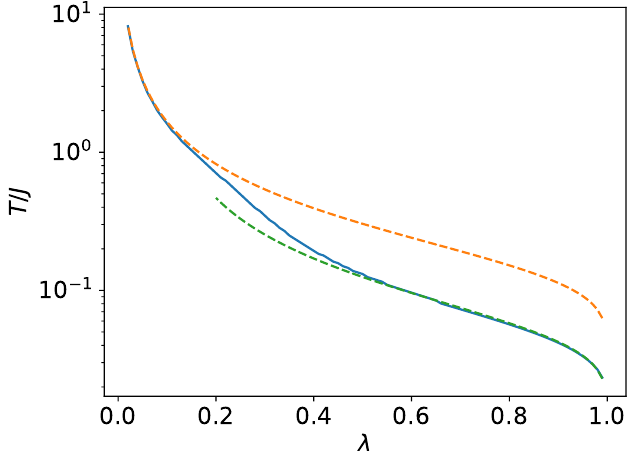
Figure 3: The temperature of the effective thermal bath as a function of λ . The blue line denotes the result from numerical optimization where T is optimized to give the highest fidelity between the steady state and the corresponding thermal state. The green dashed line is the approximated result of Eq. (33) for low temperatures, and the orange line is the approximated result of Eq. (34) for high temperatures. The parameters for numerical simulations are N = 1, M = 10, U = 0, γ = 0.001 J